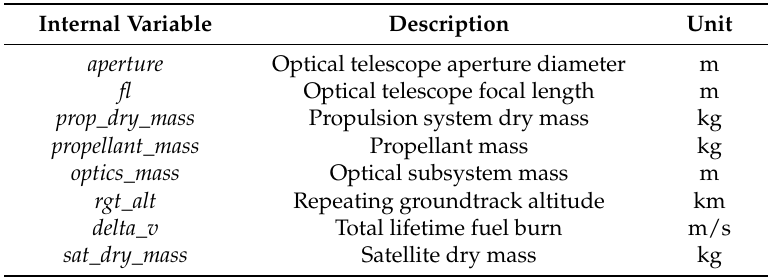
Table 3. Internal variables in ReCon simulation.